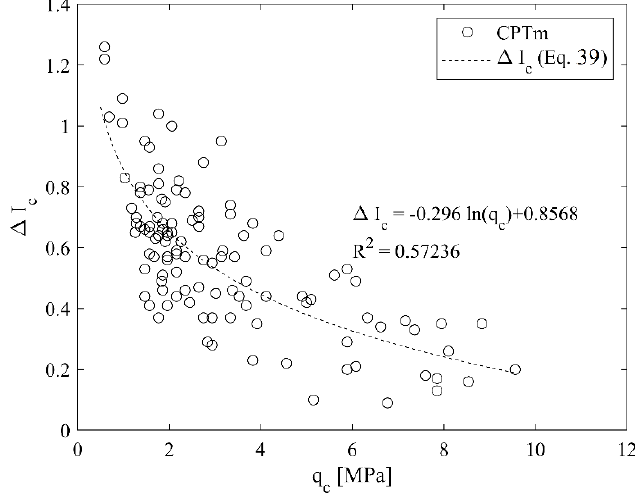
Figure 8. Variation of ∆ I c vs. q c